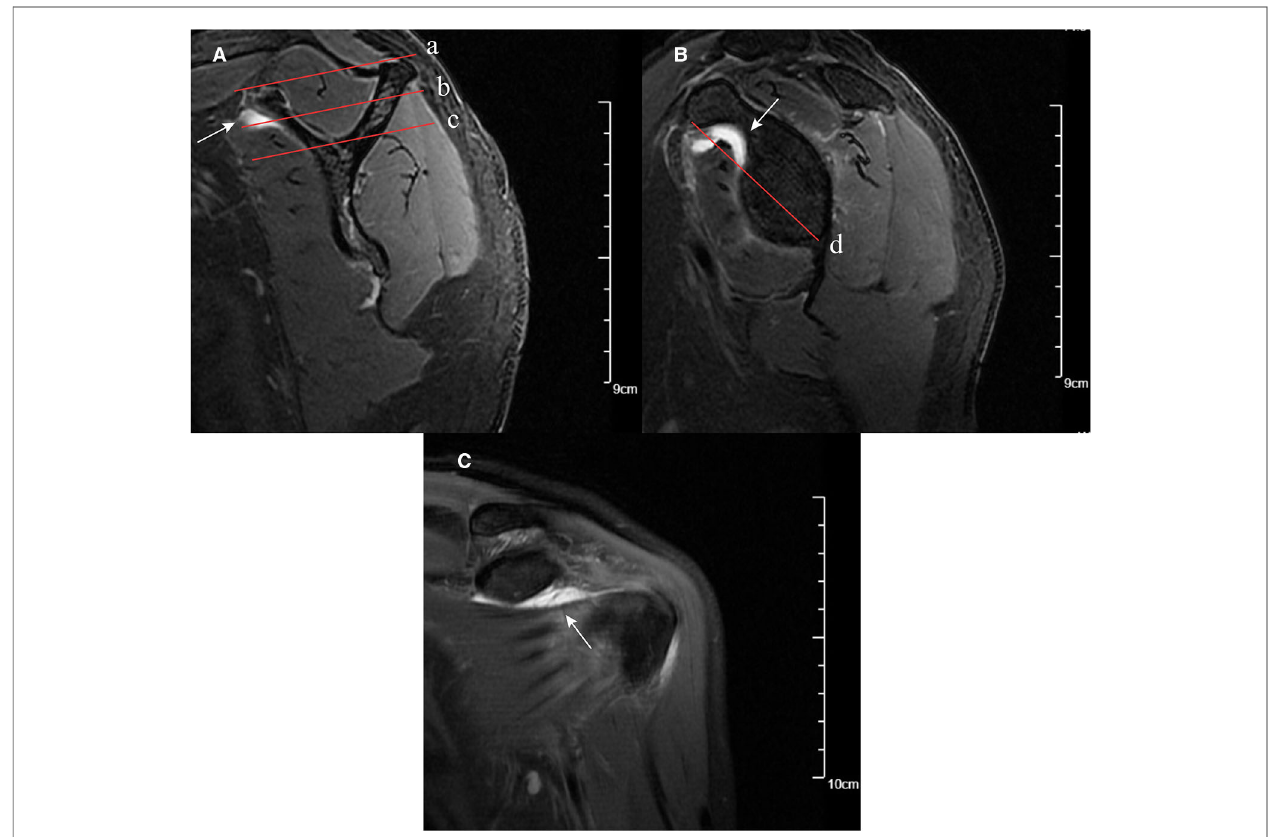
FIGURE 2 | MRI images of subscapular muscle atrophy, effusion, and fl uid area ratio (en-face). ( A ) SSC muscle atrophy classi fi cation on the Y-face plane. Parallel line intercepting supraspinatus fossa opening (red solid line a) and parallel line (red solid line b) bisecting the perpendicular distance between line (red solid line a) and line (red solid line c). Based on these lines, the SSC position was classi fi ed: between lines (a) and (b) was classi fi ed as grade (I), between lines (b) and (c) was classi fi ed as grade (II), and below line (c) was classi fi ed as grade (III). Effusion on Y-face plane (white arrow). ( B ) En-face plane showing the base to-tip line (BTL): the inferior pole of glenoid to coracoid tip on en-face (red solid line d). Using BTL, muscle atrophy of SSC is classi fi ed as grade I (tendon and muscle exist above the BTL), grade II (only tendon exists above the BTL), and grade III (tendon and muscle exist below the BTL). The fl uid area ratio was the ratio of the effusion area to the area surrounded by the coracoid process, glenoid, and BTL in the en-face. Effusion on en-face plane (white arrow). ( C ) Effusion on the coronal plane (white